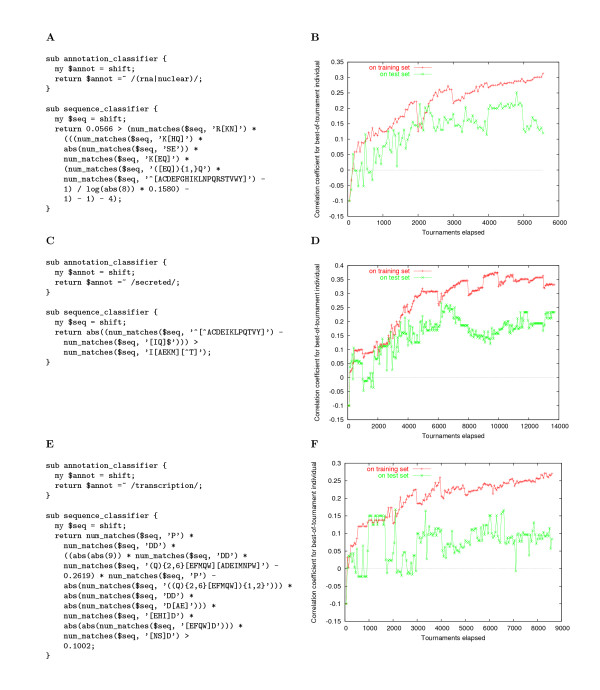
Examples of sequence-to-function relationships found by self-supervised learning. Three examples of sequence classifiers and their associated, co-evolved annotation-based classifiers are shown in panels A,C&E. In panels B,D&F, the correlation between the sequence-based classification and the annotation-based classification is shown for both training and testing data during the 8 h runs which produced the final individuals shown in panels A,C&E. Although these are hand-picked examples, note how the test set correlation generally follows the training set correlation in an upward trend. Because the test set proteins are minimally related to the training set proteins (less than 10% sequence identity), this shows that general sequence features related to function have been discovered.